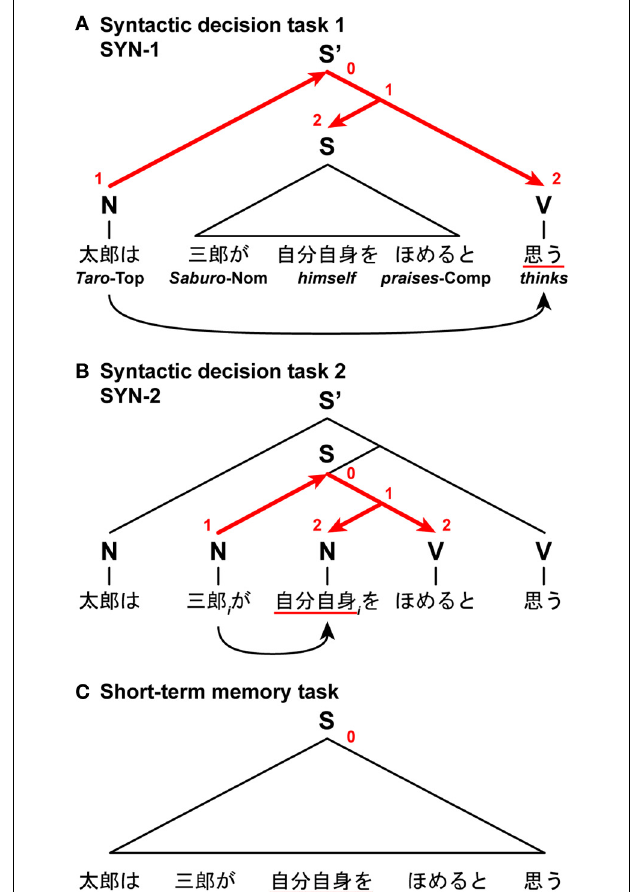
FIGURE 9 | The DoM domains varied with the Search distances and task requirements. In this task, participants read Japanese nested sentences (“ Taro-wa Saburo-ga jibunjishin-o homeru-to omou ,” “ Taro thinks that Saburo praises himself ”), in which phrases were sequentially presented. (A) A syntactic decision task 1, in which participants judged subject-verb relationships. A set of red straight arrows corresponds to the DoM domain. The digits shown in red denote the DoM for each node within the domain. (B) A syntactic decision task 2, in which participants judged noun-pronoun (coreference) relationships (subscripts denote the same entity). (C) A short-term memory task with a sentence, in which participants judged the temporal order of the phrases. Symbols used: S and S’, sentence; N, noun phrase; V, verb phrase; Top, topic; Nom,